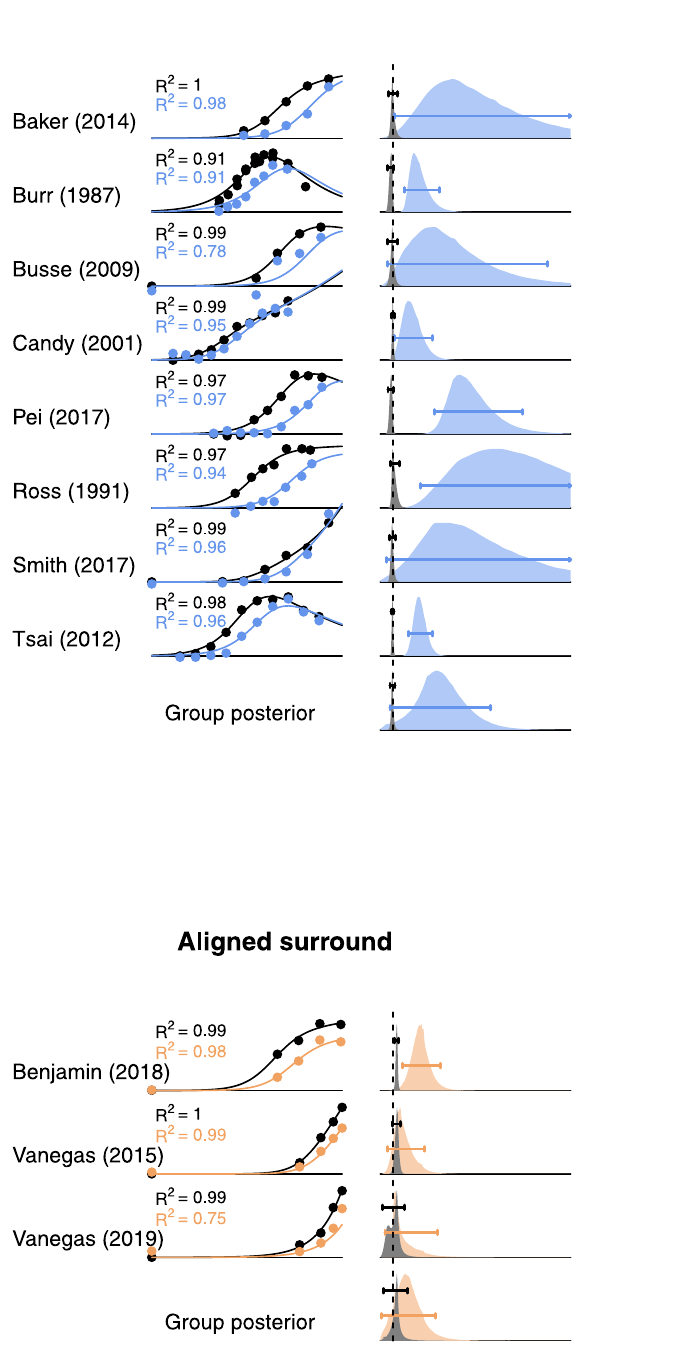
Fig 2. Computational meta-analysis of 16 studies from the literature reporting SSVEP measures of suppression. Each study is referred to by the first author surname —see text for full citations. Contrast response functions at baseline (black points) and with a mask present (coloured points) were fit using a two stage modelling procedure (curves). The posterior distributions (vertically rescaled for visibility) of parameter estimates for response gain (grey) and contrast gain (colours) are shown for each study and the group estimates. Vertical dashed lines indicate a parameter value of 1 (the axis extends to x = 15). Horizontal bars give the 95 percent highest density intervals for each parameter estimate. R 2 values in each sub-panel indicate the coefficient of determination, calculated separately for the baseline (black text) and masked data (coloured text).